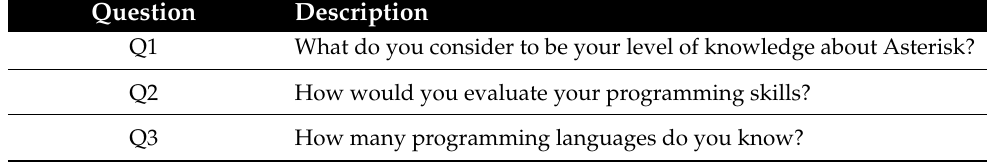
Table 1. Questions in the pretest